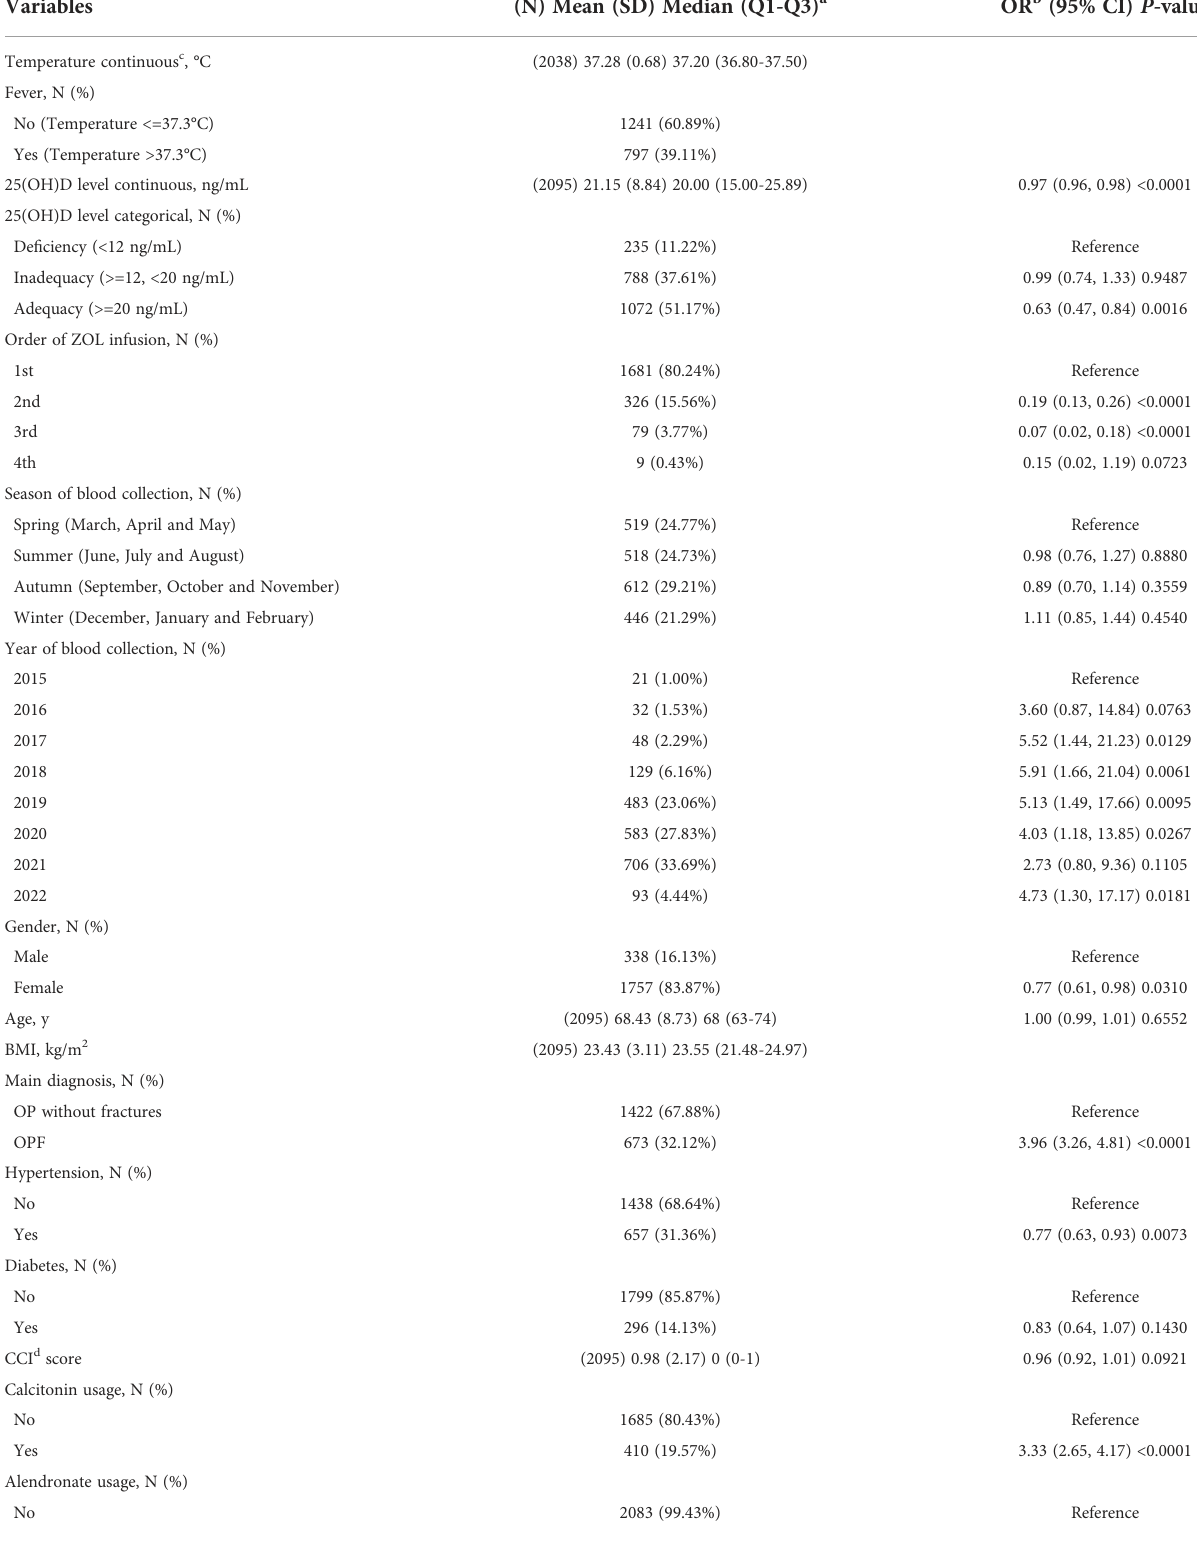
TABLE 1 Characteristics of study participants and univariate analysis for ZOL-induced fever